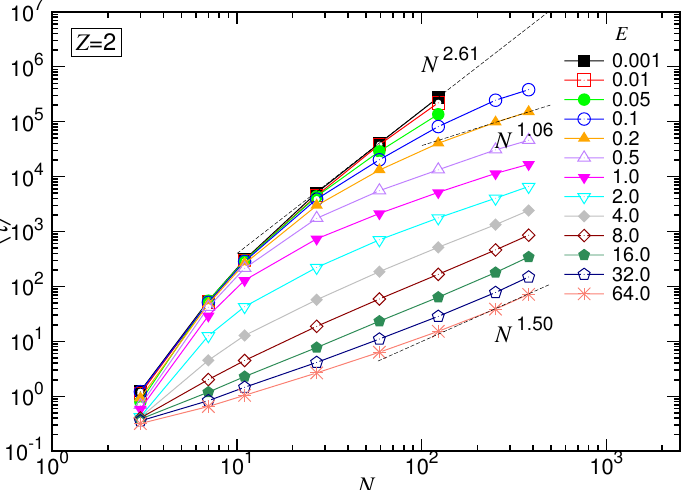
Figure 9. Mean translocation time (cid:104) τ (cid:105) as a function of the number N of the monomers transported in the divalent salt solution. The strength of the driving field E can be read in the legend. The dashed lines indicate the three characteristic scaling